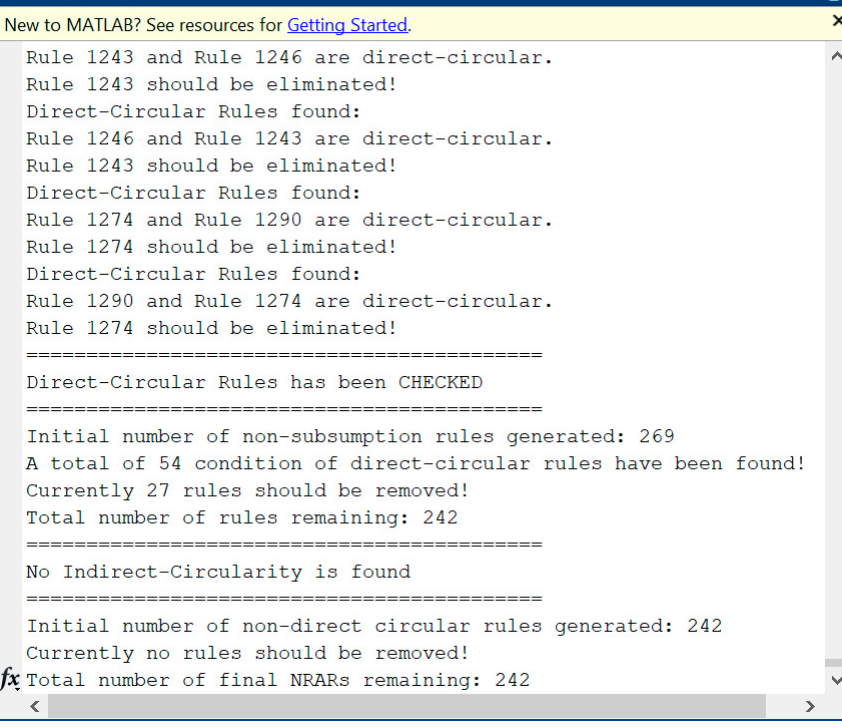
Figure 6. Screenshot of command window MATLAB after circularity checking.